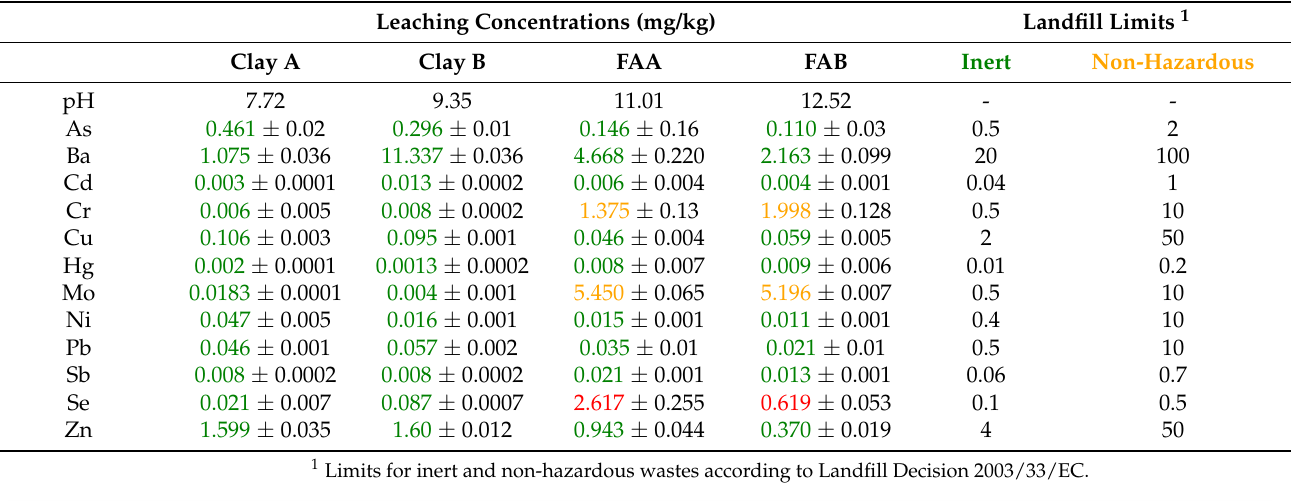
Table 3. pH values and leaching of major elements from raw materials according to the compliance leaching test EN 12457-2.